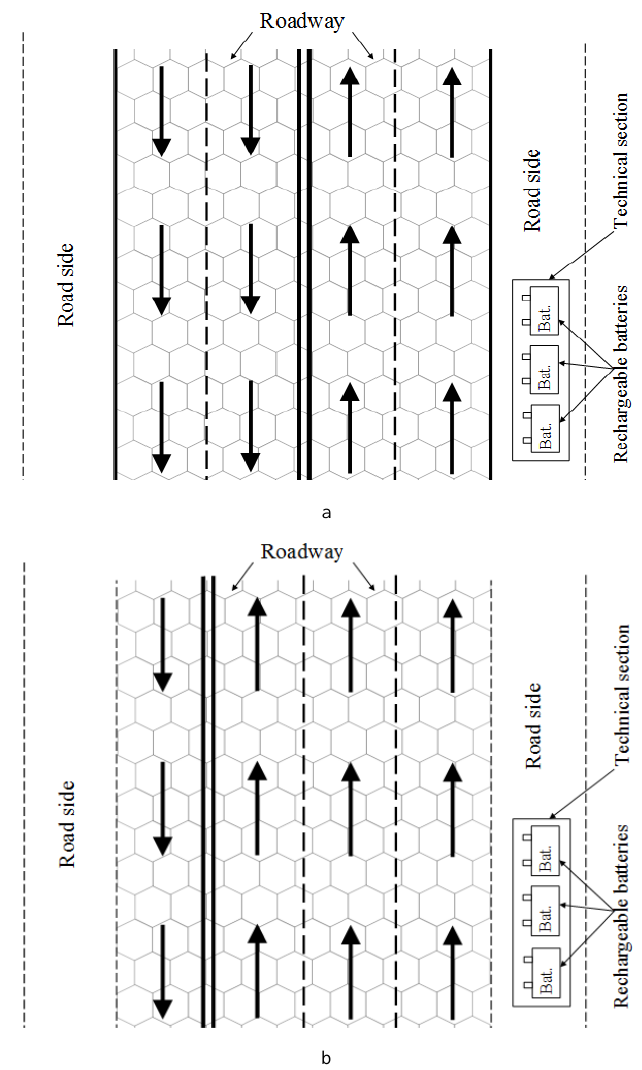
Fig. 6. Change of road marking on the road: a – before the change; b – after the change. The current research conducted by the authors allows evaluating the efficiency of the silicon PV panels in the sustainable energy efficient road pavement depending on the electrical load conditions. As this load can change (it is connected, for example, with the change of weather conditions or the time of the day), it is offered to use solar controller MPPT for monitoring of conditions under which silicon PV panels will work with maximum efficiency